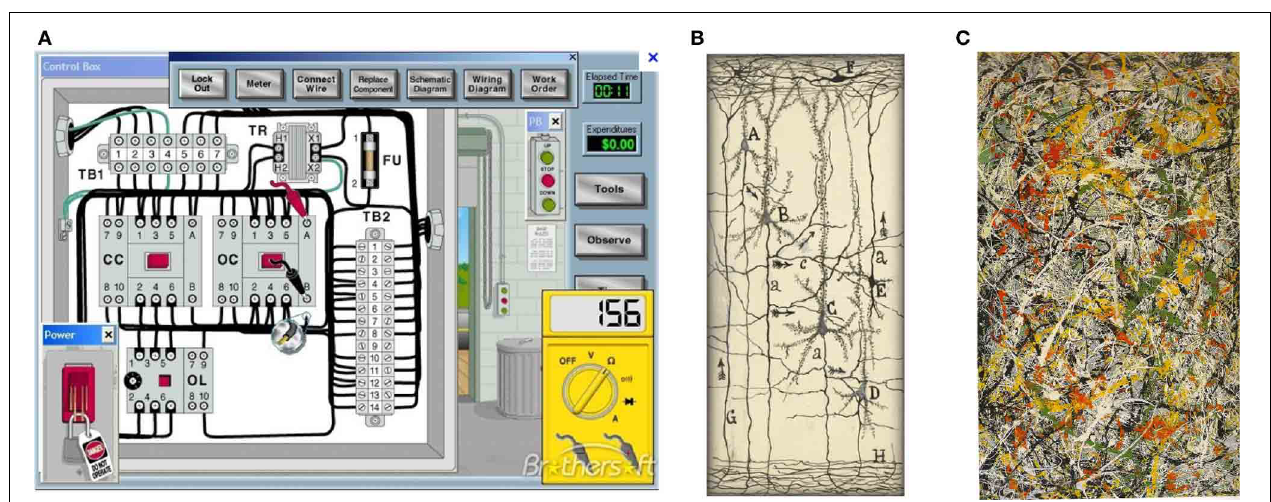
FIGURE 2 | (A) Circuit for electric motor. (Note the insulating spaces between wires and components). (B) Cajal drawing of a neural circuit (from Garcia-Lopez1 et al., 2010; DeFelipe, 2011). (Note the empty spaces around